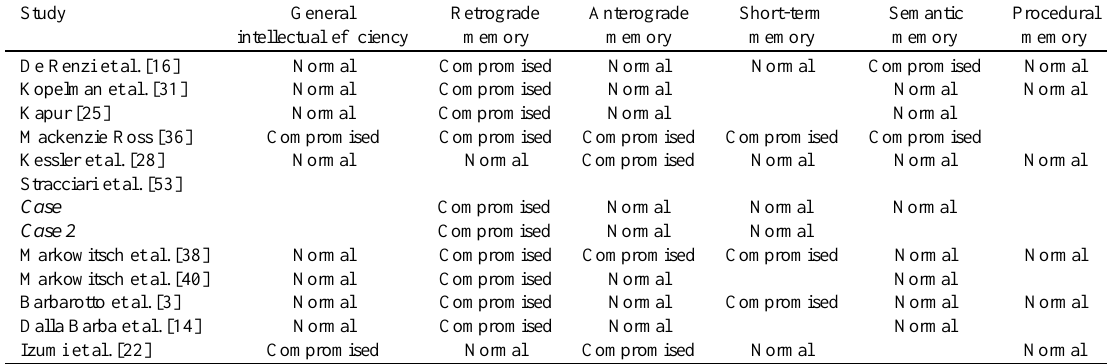
Table 2 Neuropsychological data in selected cases of psychogenic amnesia in the